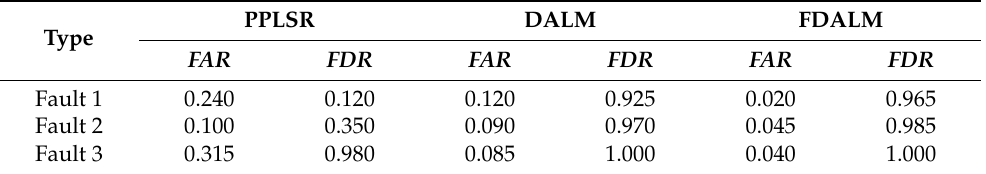
Table 3. Monitoring results for different faults.